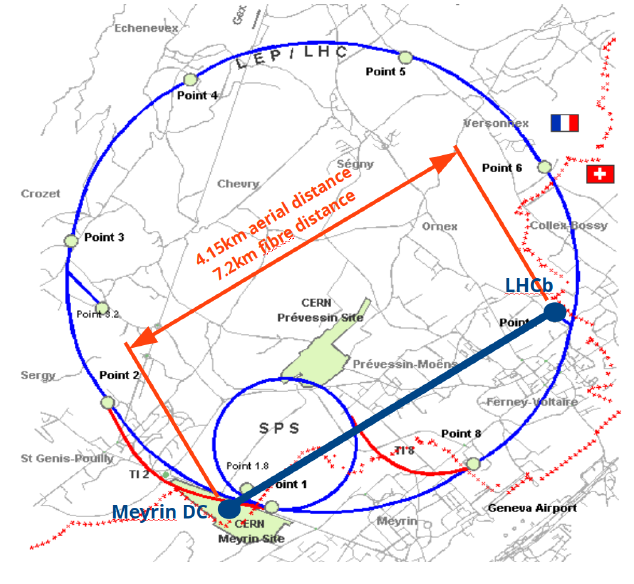
Figure 1. A proposal for a shared HLT facility.